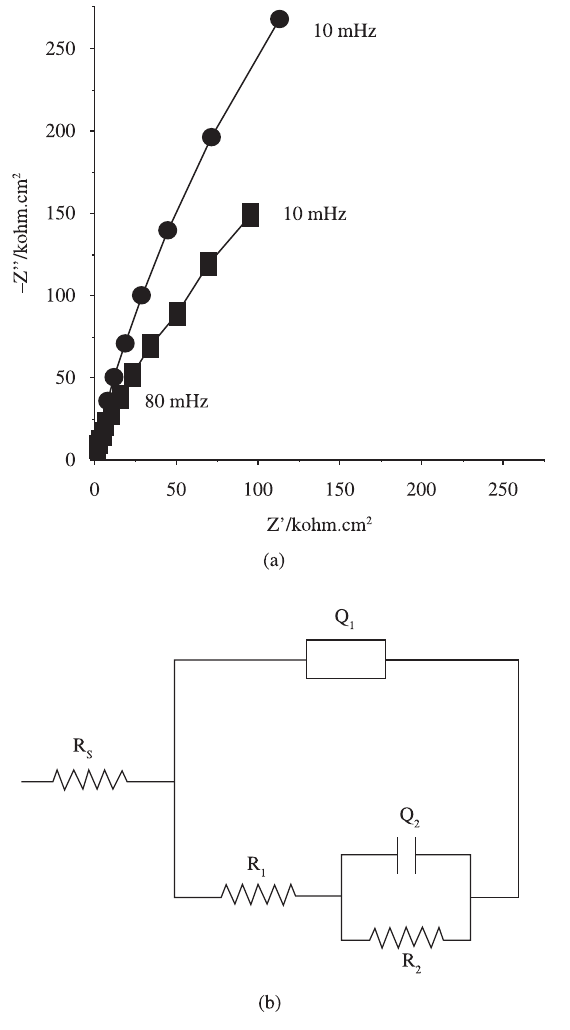
line. b) Equivalent circuit; Rs(Q